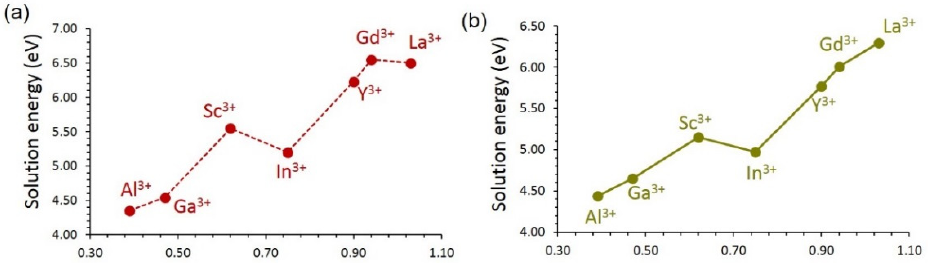
Figure 9. Solution energy of M 2 O 3 forming oxygen vacancies with respect to the M 3+ ionic radius in ( a ) LiVSi 2 O 6 and ( b ) NaVSi 2 O 6 .